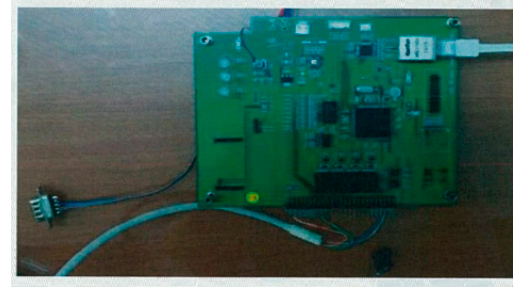
Figure 16. Hardware of beacon gateway.